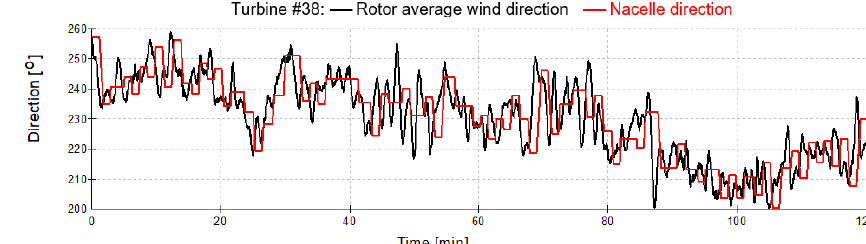
Figure 6. Typical simulated yaw control response.